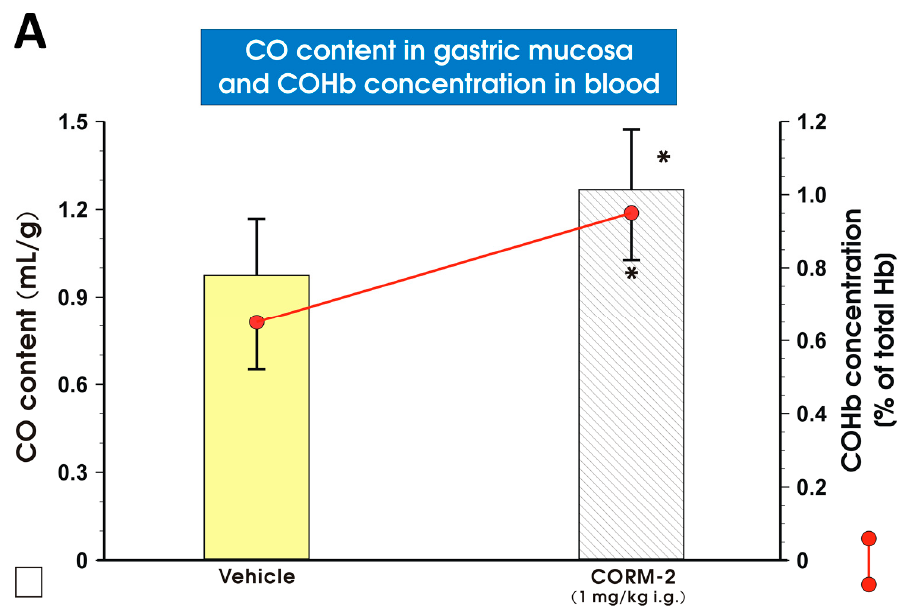
Figure 7. Cont. Figure 7.